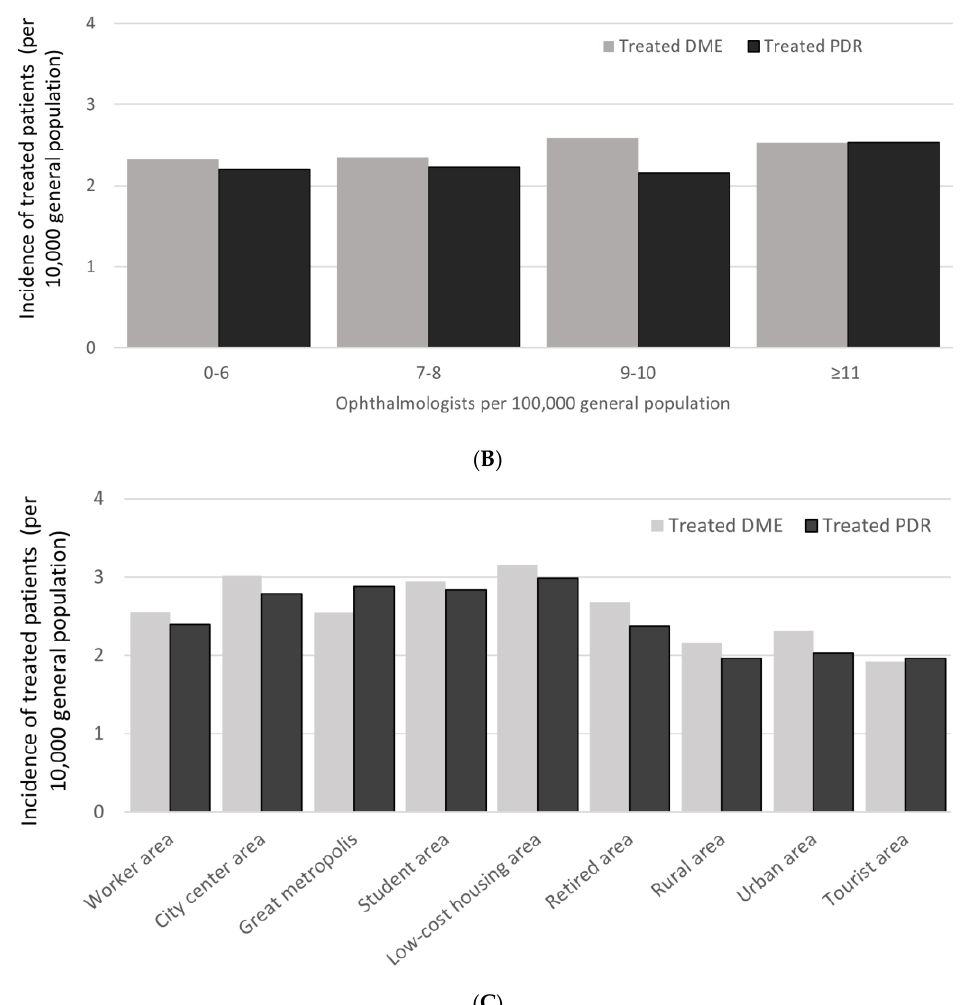
Figure 4. Treated DME and PDR incidence in the general population in 2018, by frequency of ( A ) general practitioners (GPs) and ( B ) ophthalmologists in residential area and ( C ) by type of patient residence.